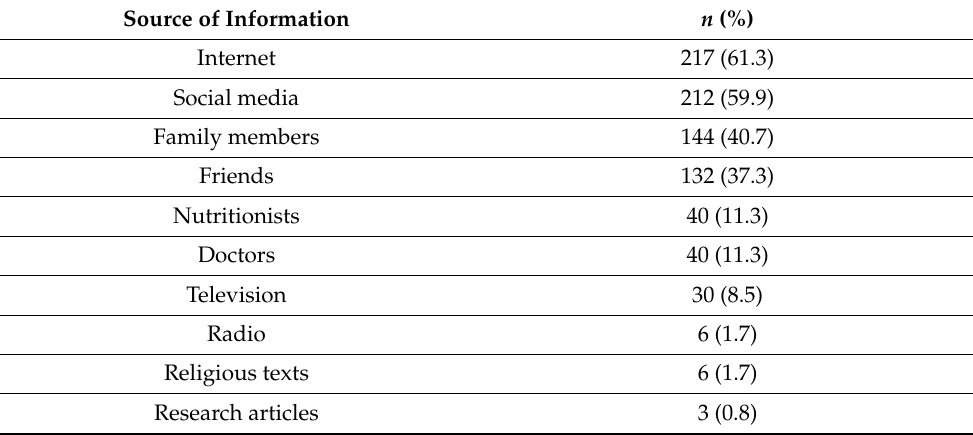
Table 6. Sources of information about HDSs among the respondents who did not consult CPs about HDSs ( n =